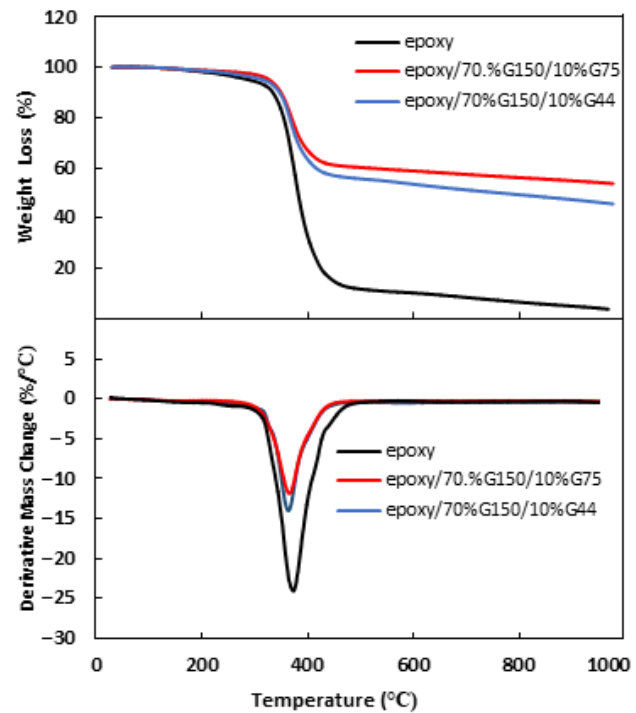
Figure 7. TGA and DTG curves of pure epoxy, epoxy/G150/G44 and epoxy/G150/G75 composites at 70 wt.% G150 and 10 wt.% G44 or 10 wt.% G75 prepared at 150 °C for 120 min.